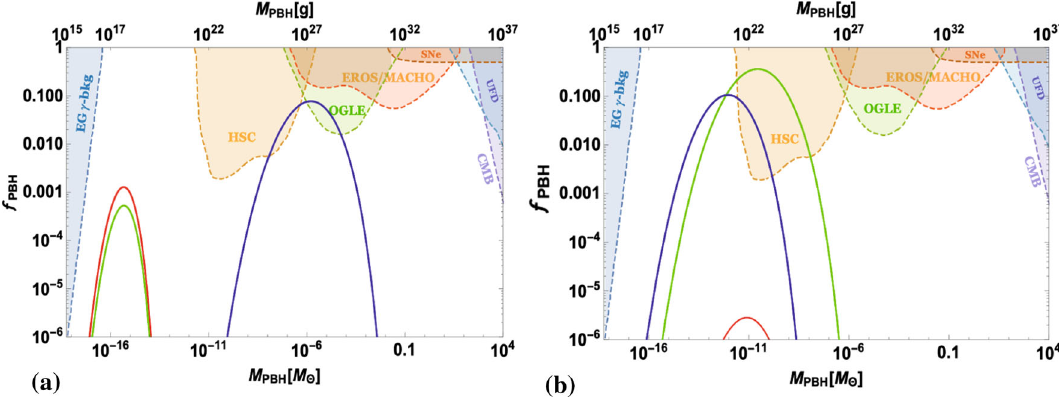
Fig. 5 Leftpanel: for q = − 1 and n = 1, Dark matterfraction( f PBH ) as a function of the primordial black hole mass ( M PBH ) in the unit of M (cid:2) is plotted. Three different colors correspond to three differ- ent values of potential parameter x and m . Red color corresponds to x = 0 . 45018 , m = 3 / 5, green is for x = 0 . 6140 , m = 1 / 2 and blue stands for x = 0 . 50117 , m = 2 / 5. Right panel: for q = − 1 and n = 2,